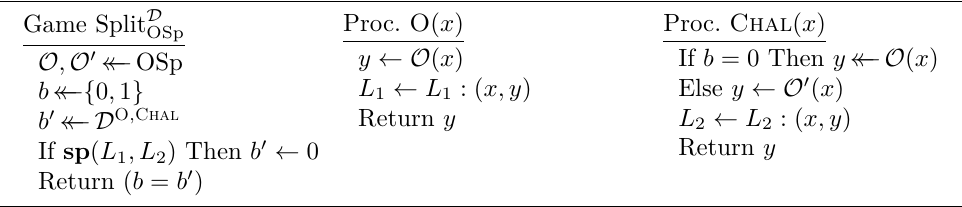
Figure 4: Game defining oracle splittability with respect to relation sp